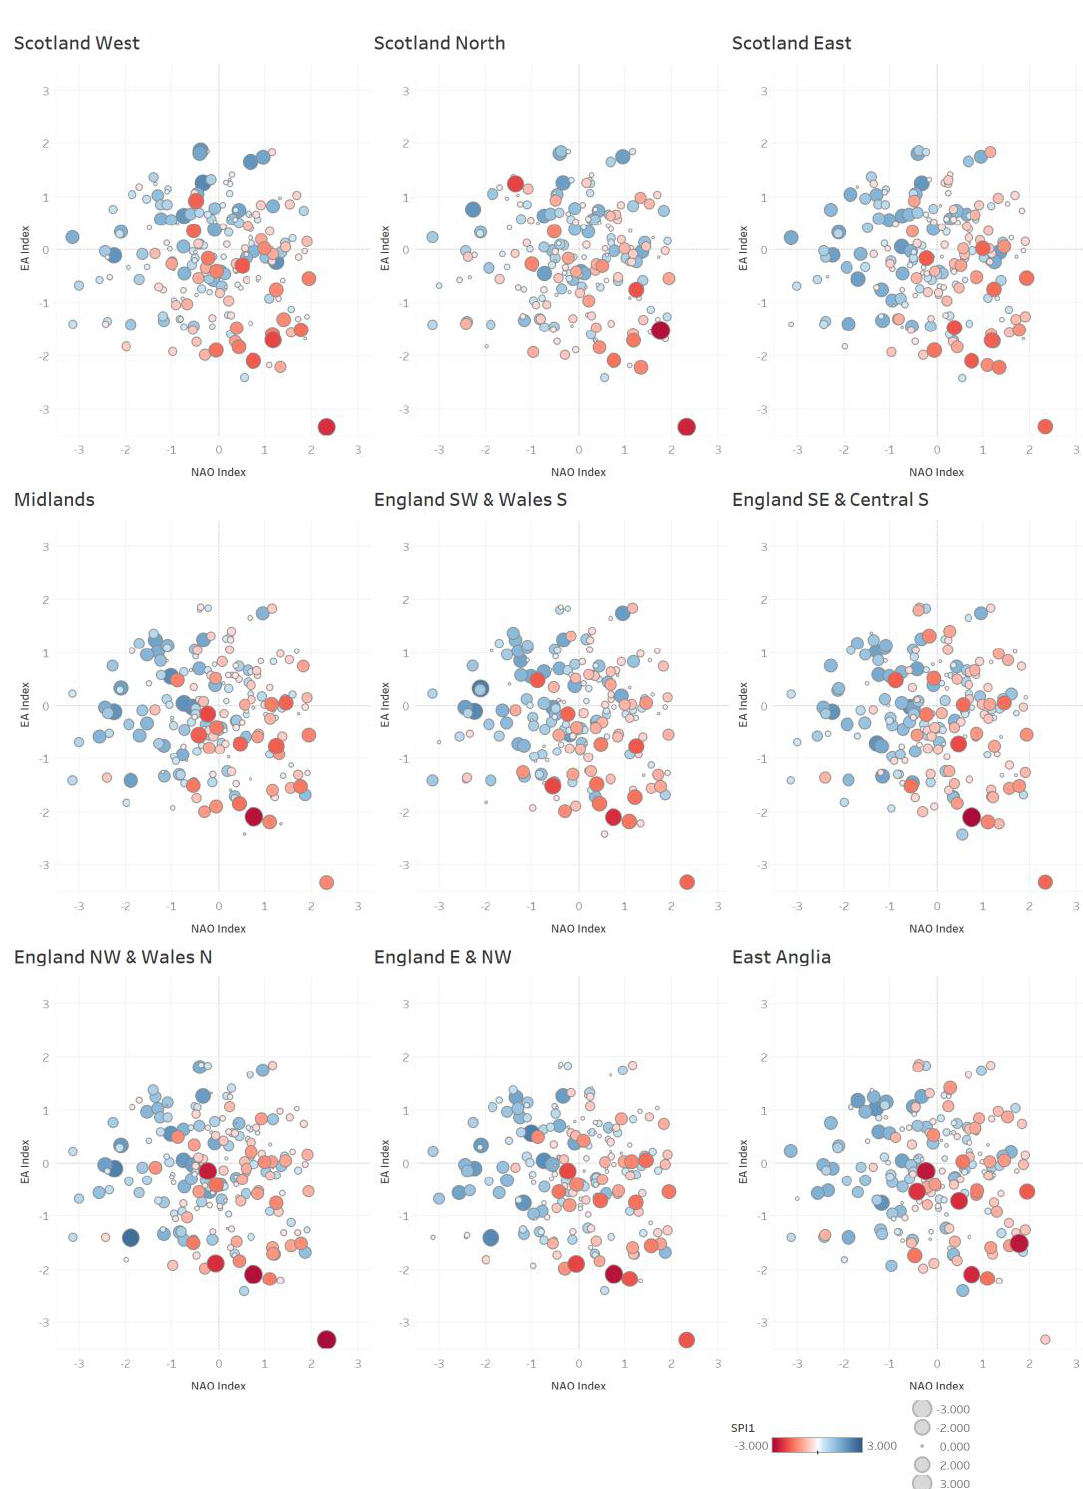
Figure 7. As per Figure 6; however showing the NAO and EA indices for the summer (JJA)